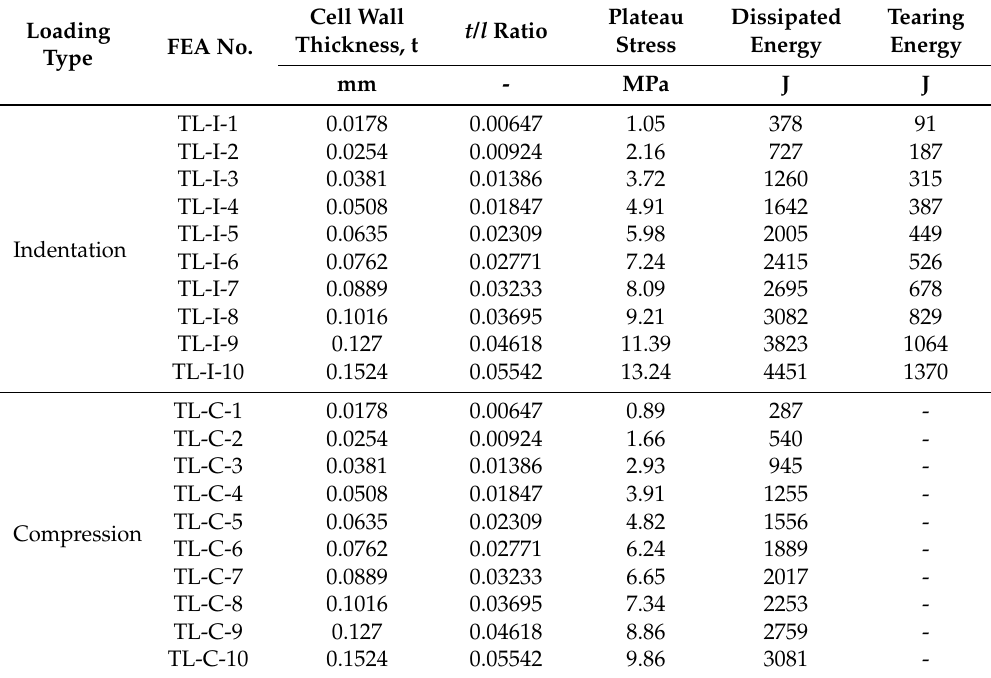
Table 6. FEA results of honeycombs with constant cell size and different cell wall thicknesses.